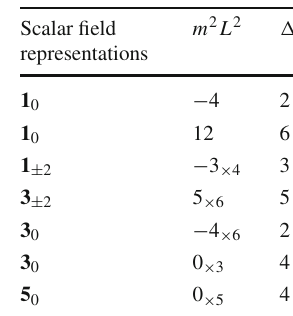
Scalar field representations